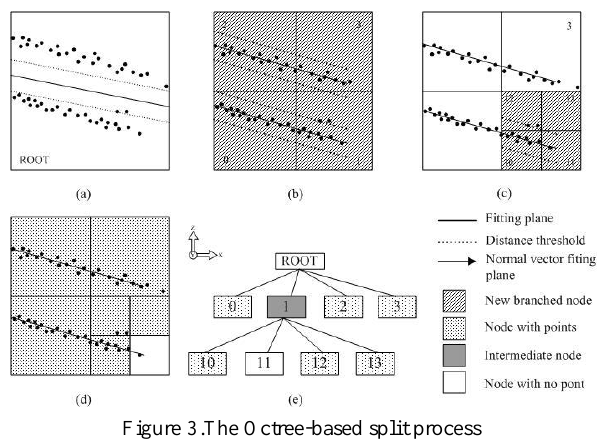
Figure 3.The Octree-based split